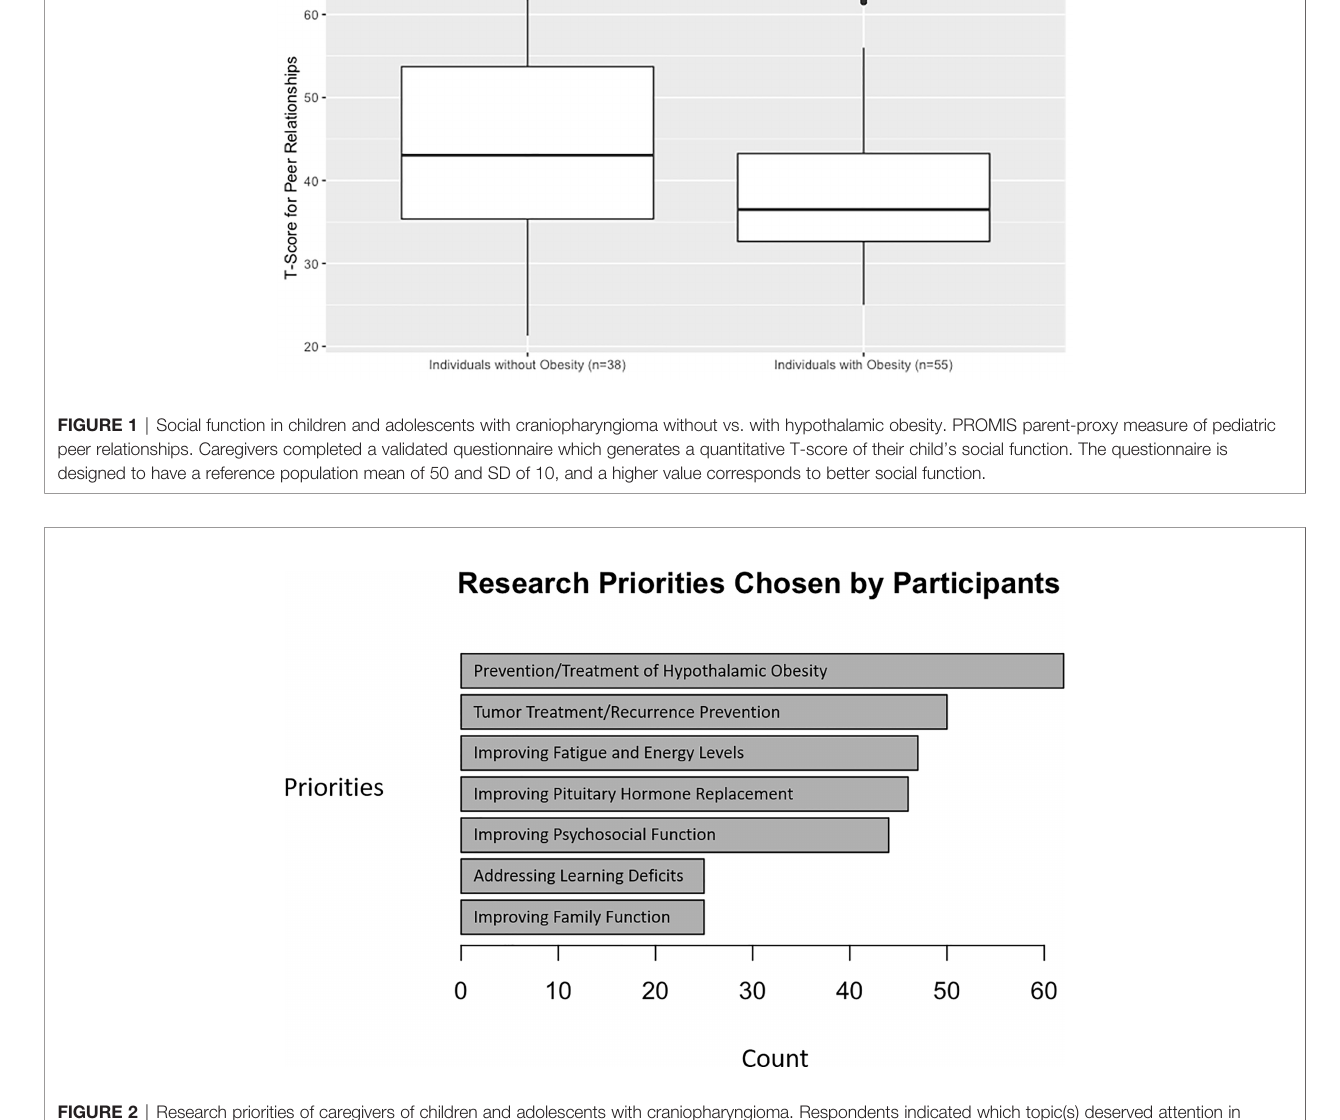
FIGURE 2 | Research priorities of caregivers of children and adolescents with craniopharyngioma. Respondents indicated which topic(s) deserved attention in research related to